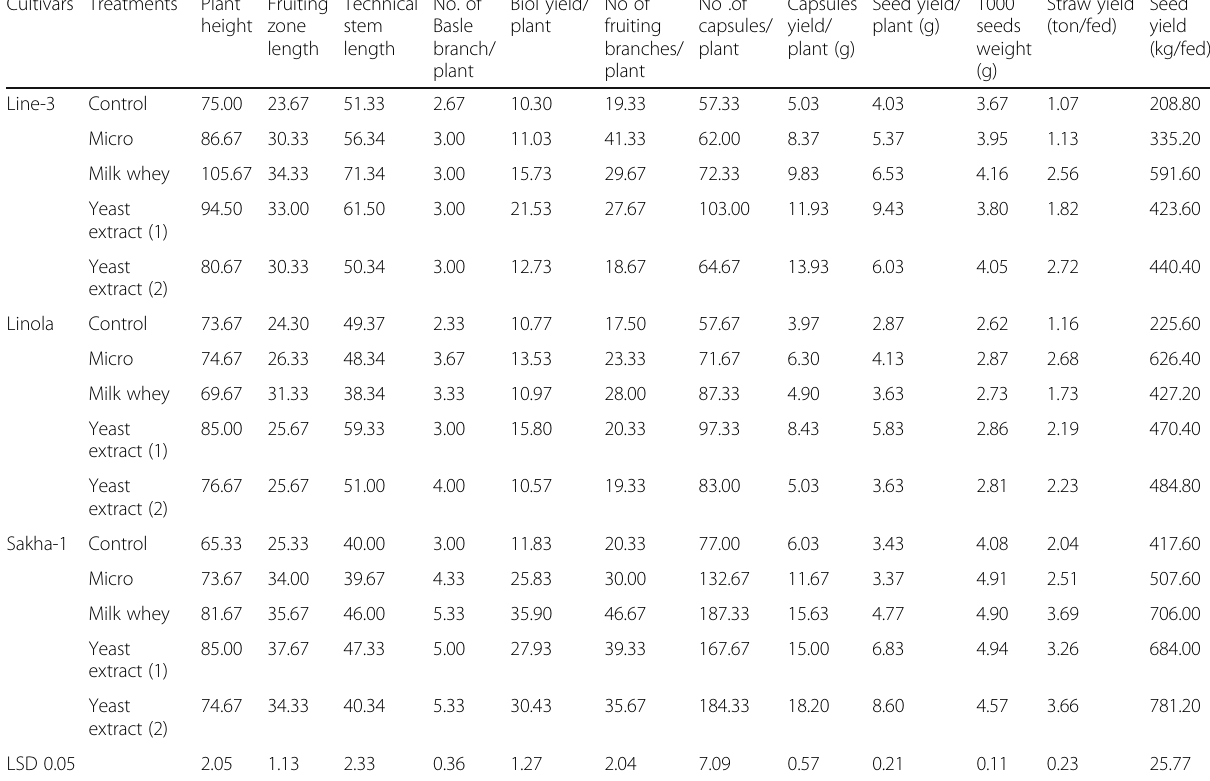
Table 9 Effect of interaction between flax cultivars and bio-fertilizer treatments on seed, straw yield, and its related characters of flax cultivars grown under sandy soil conditions Cultivars Treatments Plant Fruiting height zone